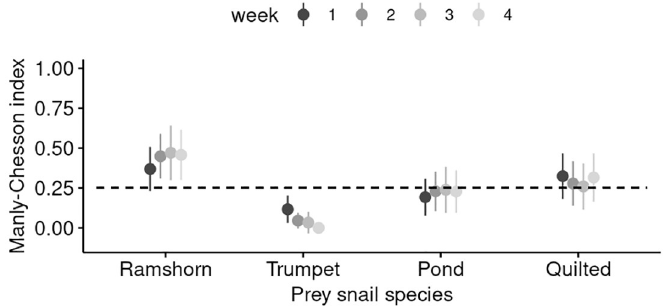
Fig 4. Weekly prey preference during the four week treatment. Preference of A. helena for each of the prey species in the four week feeding trial (prey composition: 1R:2T:1P:4Q). Mean values for all snails with ± 95% CI. CI’s overlapping with the dashed line (expected consumption under random feeding per prey type) indicated no